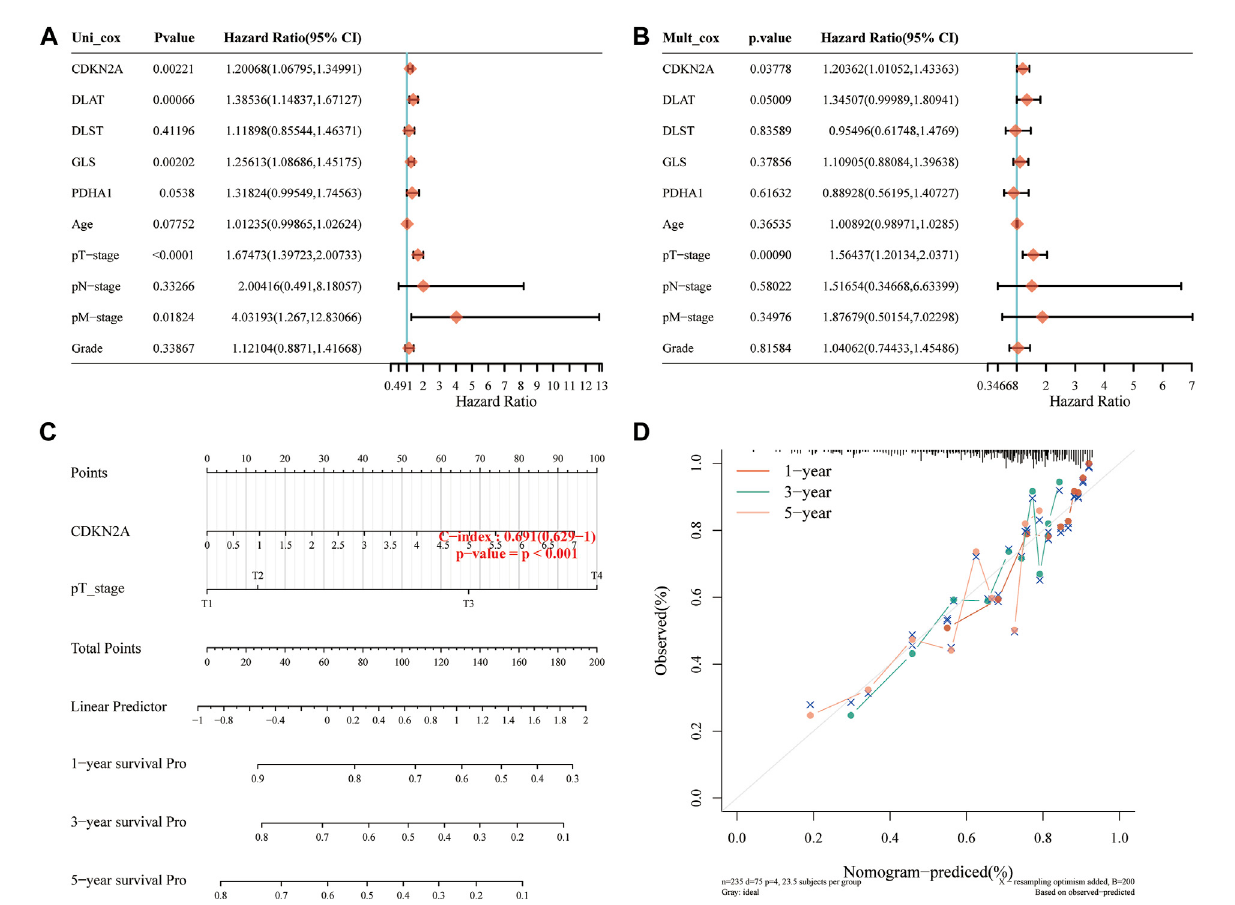
FIGURE 7 Construction of a predictive nomogram. (A, B) Hazard ratios and p -value of the constituents involved in univariate and multivariate Cox regression analysis considering the clinical information and prognostic CRGs in HCC. (C) Nomogram to predict the 1-year, 3-year and 5-year OS rate of HCC patients. (D) Calibration curve for the OS nomogram model in the discovery group. The dashed diagonal line represents the ideal nomogram. OS, overall